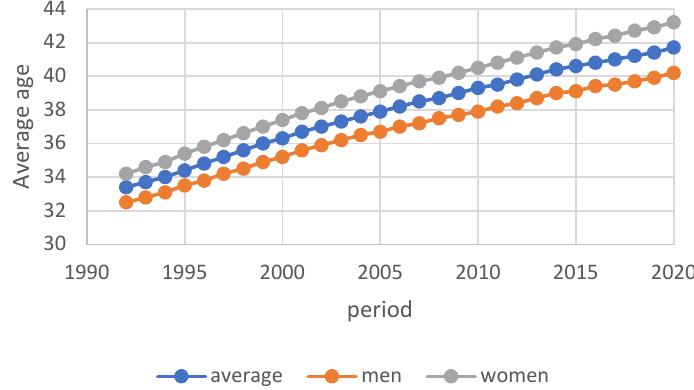
Figure 3. Evolution of average age for the investigated period.